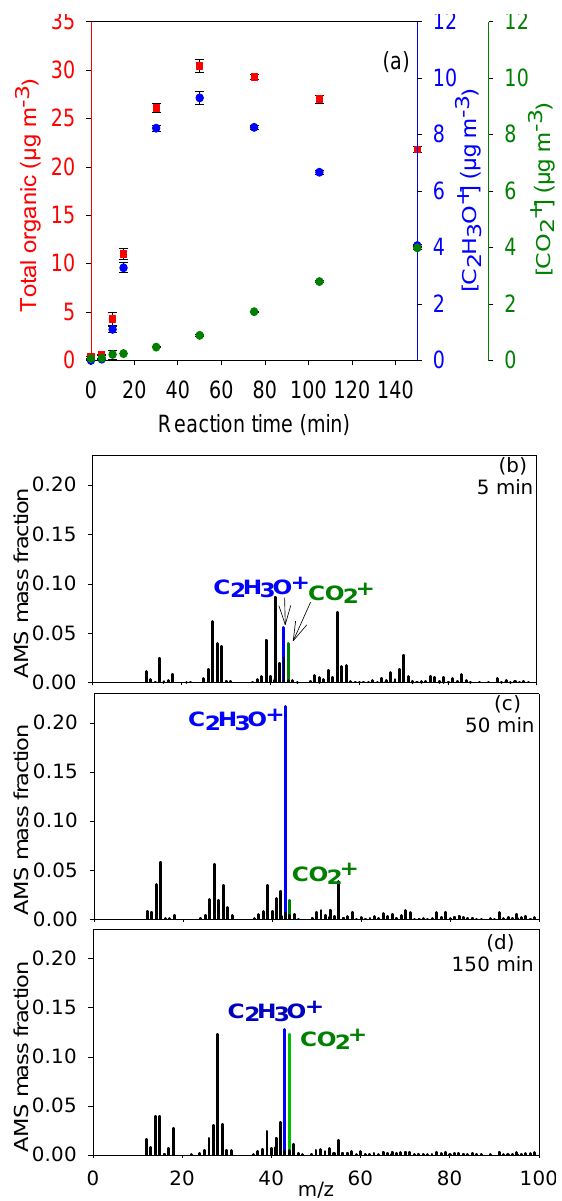
Figure 3. Time profiles of the HR-ToF-AMS total organic mass (red), ion fragments C 2 H 3 O + at m/z 43 (blue) and CO + (green) for nebulized solutions from experiment B (a) , and the cor- responding evolution of HR-ToF-AMS mass spectra (for m/z 0– 100) for nebulized solutions sampled after 5min (b) , 50min (c) and 150min (d) . Values are averages of five consecutive HR-ToF-AMS runs; error bars represent their standard deviations. The AMS mass fraction is the signal intensity contribution of each fragment to the total signal.